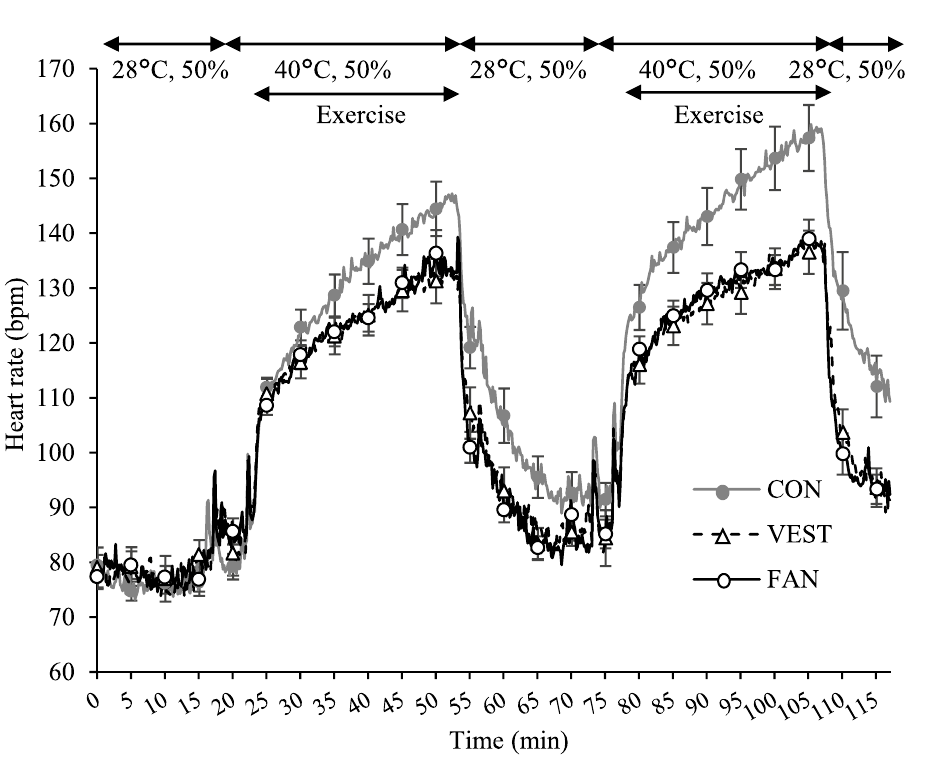
Figure 3. Heart rate in the CON, VEST, and FAN conditions. Data at every 5 min are presented as the mean ± standard error. CON participants did not wear any cooling garment, VEST participants wore a circulating-water cooling vest, FAN participants wore a fan-attached jacket. Number of participants: